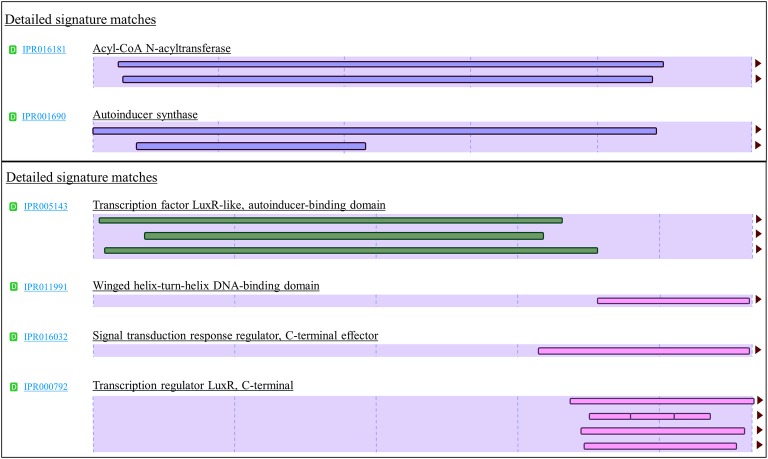
Signature InterPro domain of LuxI (top) and LuxR (bottom). LuxI of Pandoraea species contain two signature domains (IPR016181 and IPR001690), while LuxR of Pandoraea species contains four signature domains (IPR005143, IPR011991, IPR016032, and IPR000792).